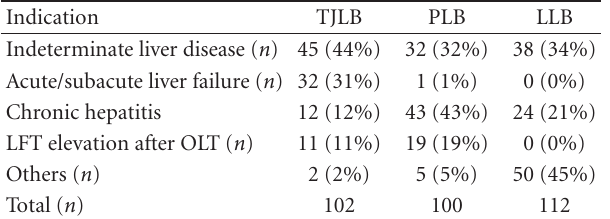
Table 1: Distribution of di ff erent patient groups to liver biopsy methods